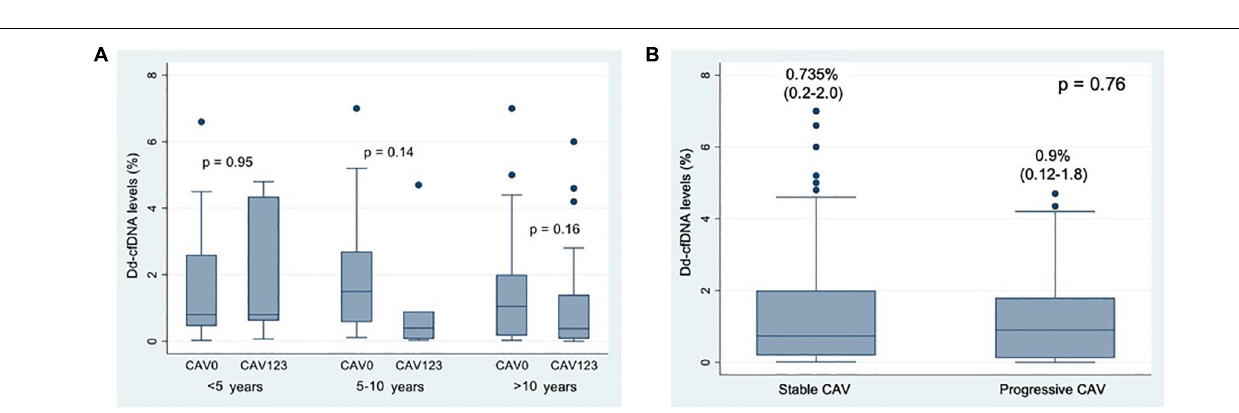
FIGURE 3 | Area Under the Curve Receiver Operating Characteristics (AUC ROC) curve for the diagnosis of CAV0 vs. CAV123.